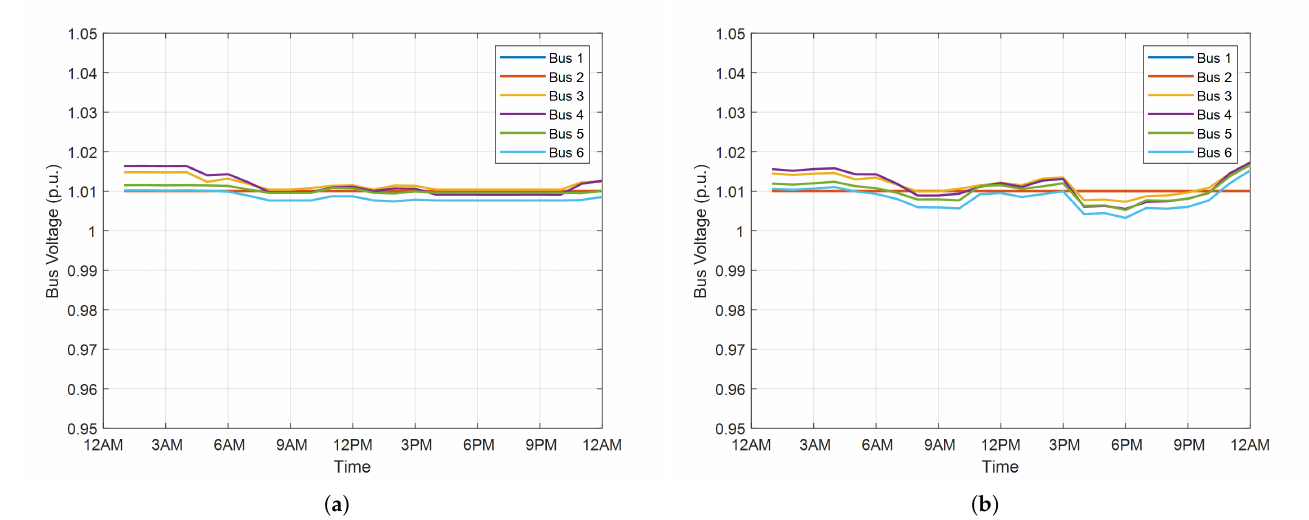
Figure 9. Bus voltage profiles in islanded mode. ( a ) Centralized Method. ( b ) Distributed